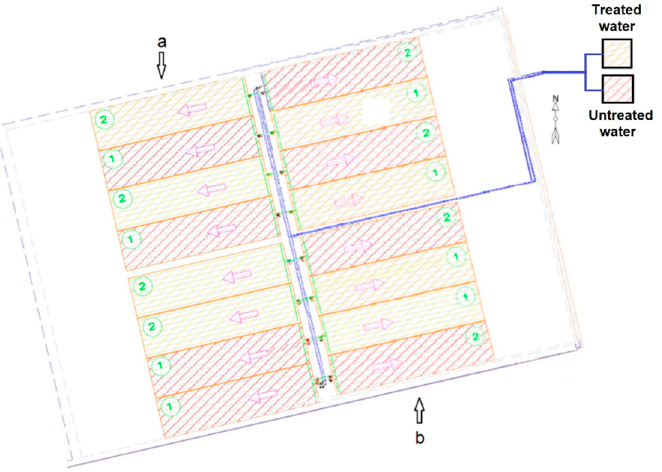
Figure 5. Distribution of ( a ) lettuce and ( b ) radish crops in the experimental plots. Water flows in the direction of arrows, piping in blue. Yellow plots: irrigation with treated water; purple plots: irrigation with untreated water.